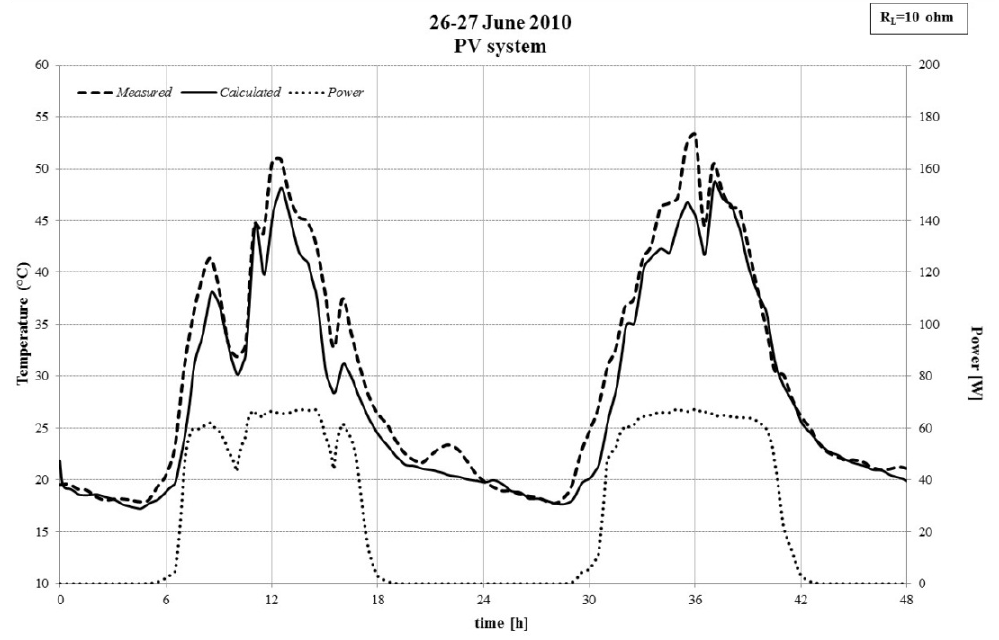
measured power output, in Palermo, 26–27 June 2010.